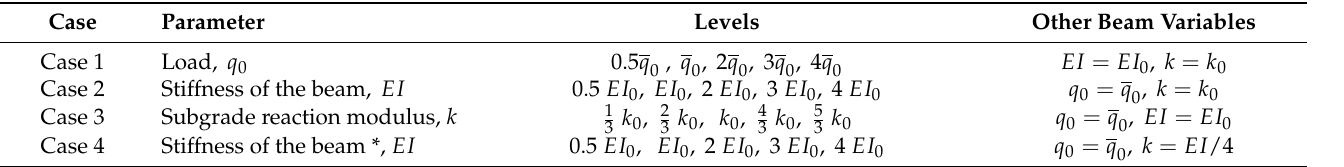
Table 2. The adopted parameters and their levels .